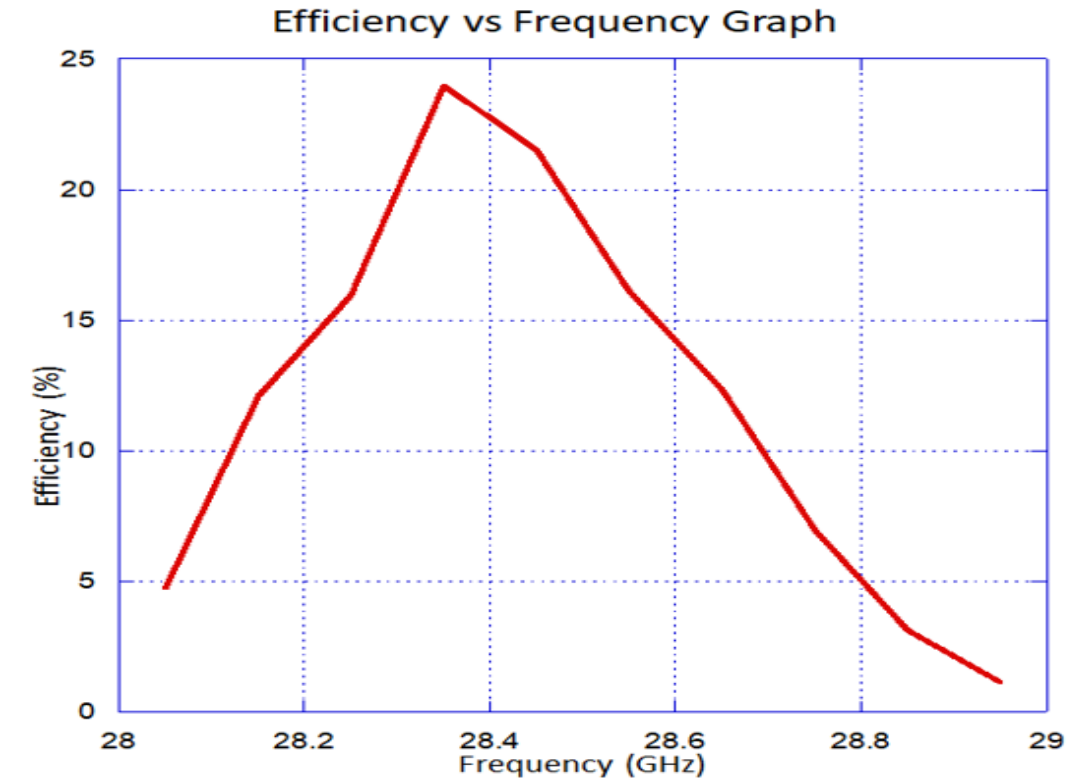
Figure 19. Graphical representation of efficiency vs. frequency.